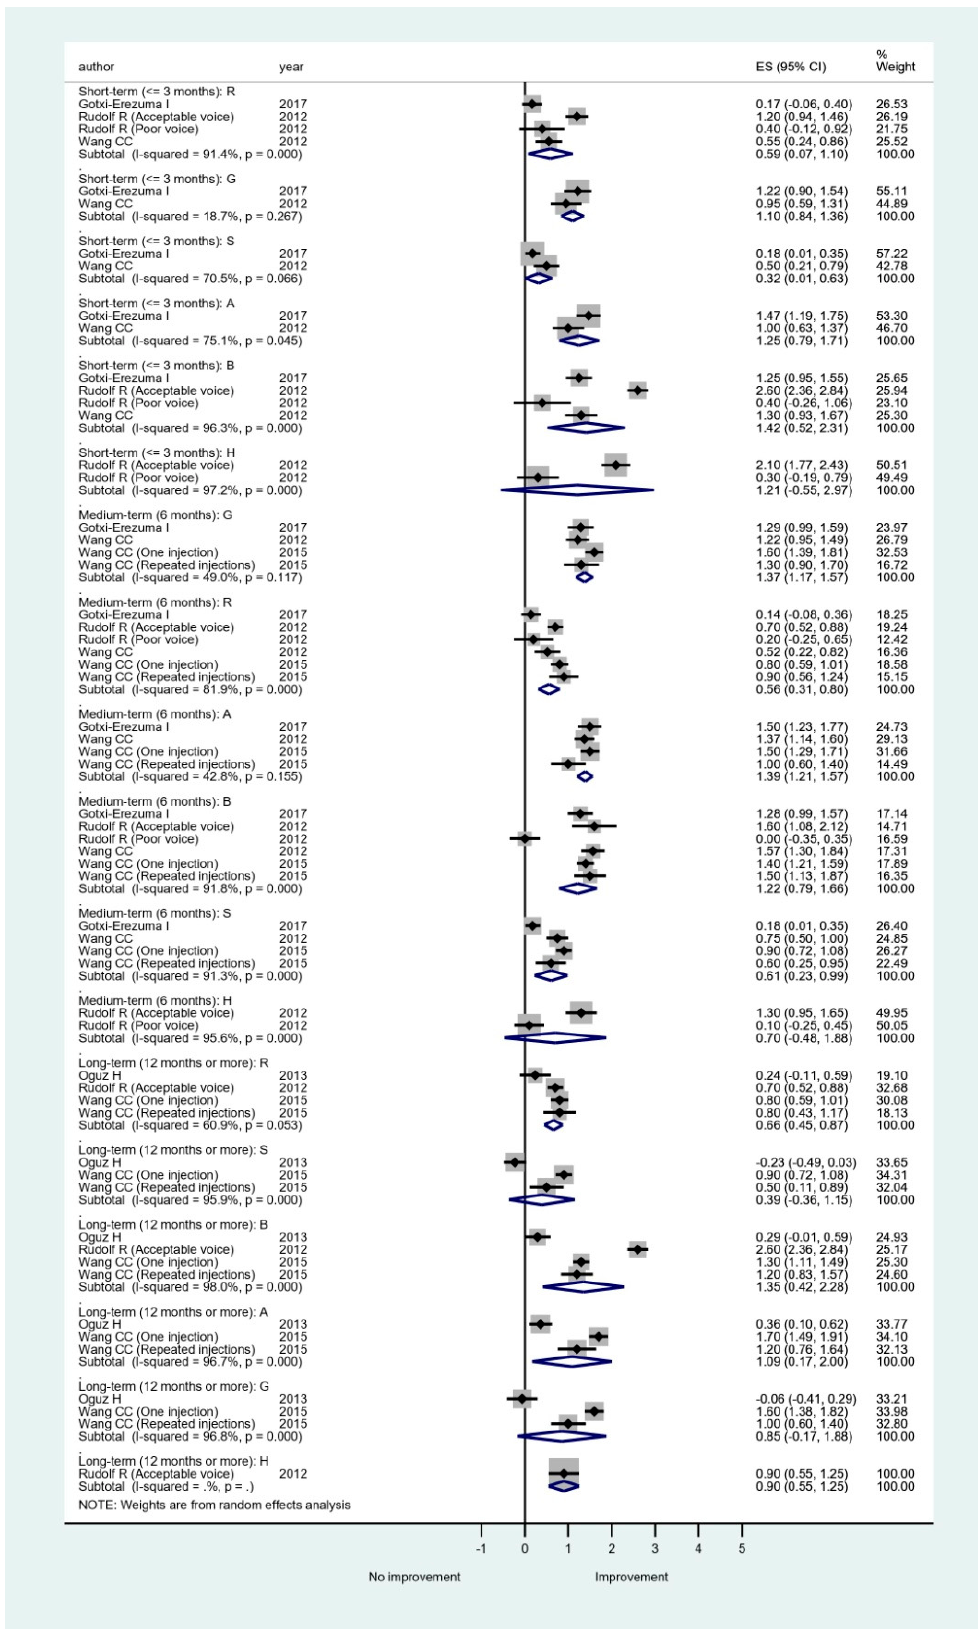
Figure 3. Subgroup meta-analysis of overall grading of different items of perceptual evaluation (G, R, B, A, S and H) in short-term, medium-term, and long-term follow-up after hyaluronic acid injection laryngoplasty.